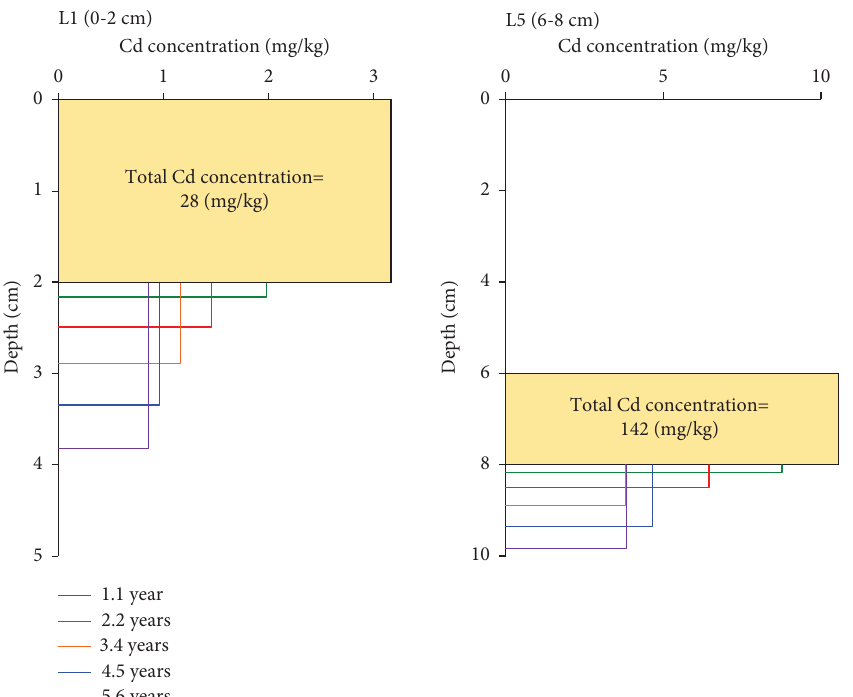
Figure 5: Calculated migration depth of Cd from the sediment layers at 0–2 cm and 6–8 cm (core L